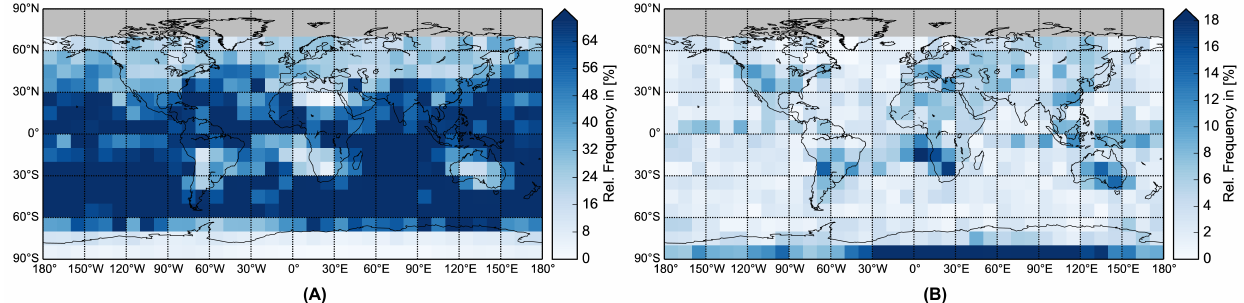
Figure 4. Application frequencies of the IAB filters relative to all NCR and occurrence frequencies of filtered NCR features relative to the filtered | CAD |≤ 100 range for August